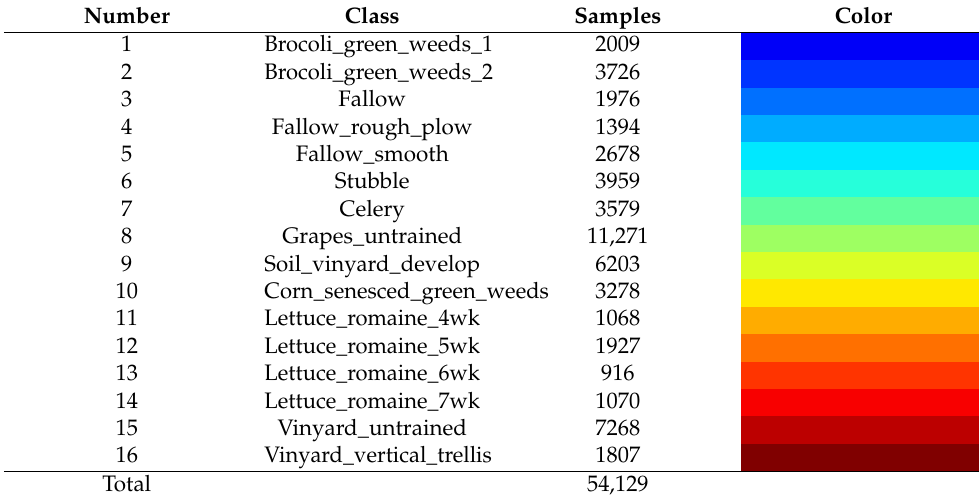
Table 4. The information of each class in SA.